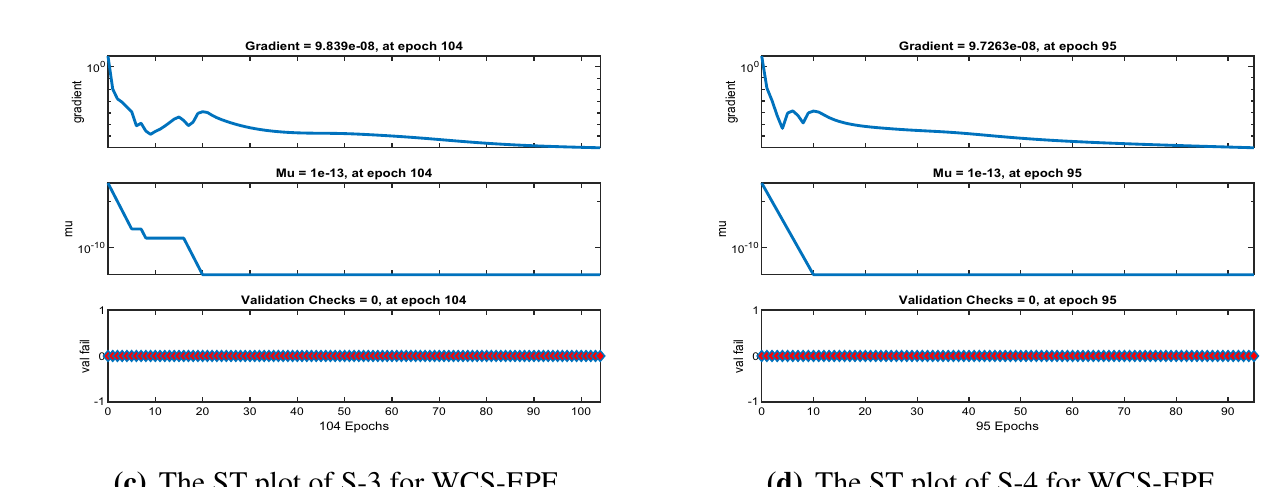
(d) The ST plot of S-4 for WCS-EPF. Figure 7. The state transition (ST) for Case2 in constant